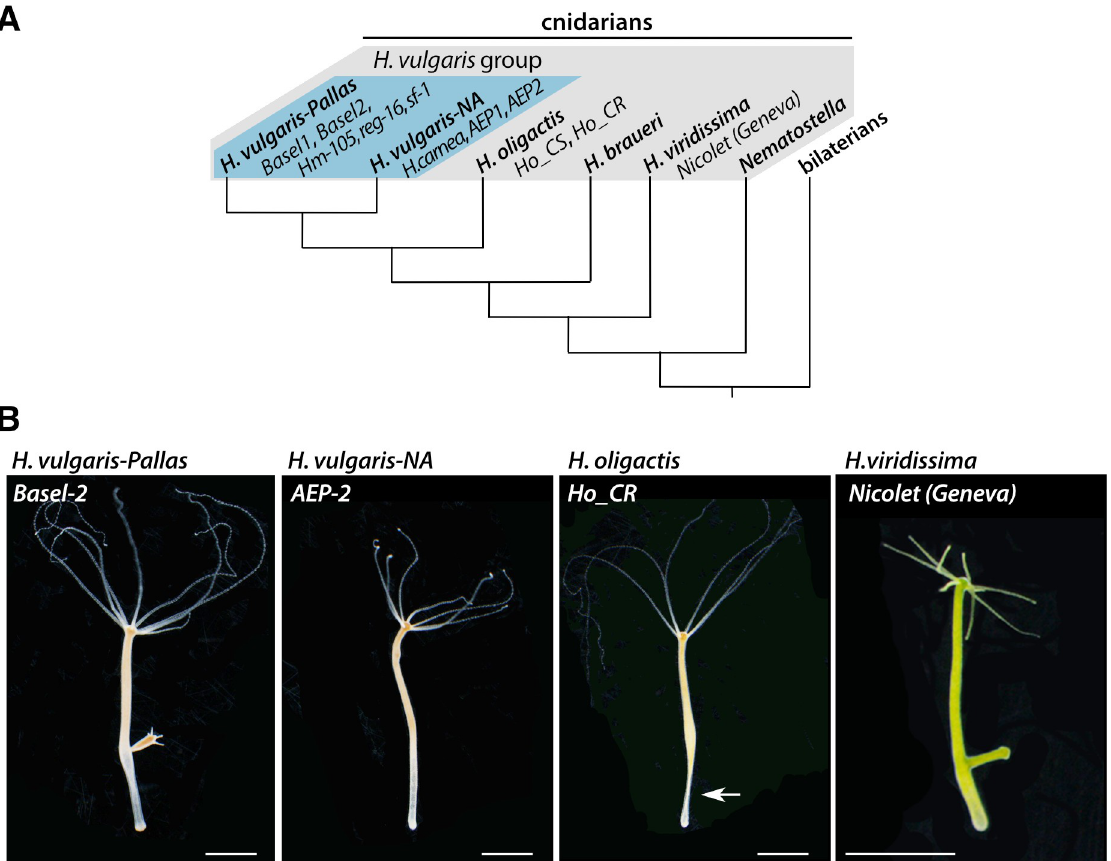
Fig 1. Phylogenetic position and morphology of the freshwater Hydra polyps. (A) Schematic view of the phylogeny of the four groups of Hydra species as reported in references 13–16: H . vulgaris with the sub-groups H . vulgaris-Pallas and H . vulgaris-NA (blue background), H . oligactis , H . braueri , and H . viridissima . (B) Images of polyps illustrating the similar overall appearance between strains and species despite differences in developmental and cellular responses: H . vulgaris-Pallas (Basel-2 strain) , H . vulgaris-NA (AEP-2 strain) , H . oligactis (Cold- resistant strain , Ho_CR) and H . viridissima (Nicolet-Geneva strain) groups. Note the stalk peduncle (arrow) typical of the H . oligactis species. Scale bars: 2